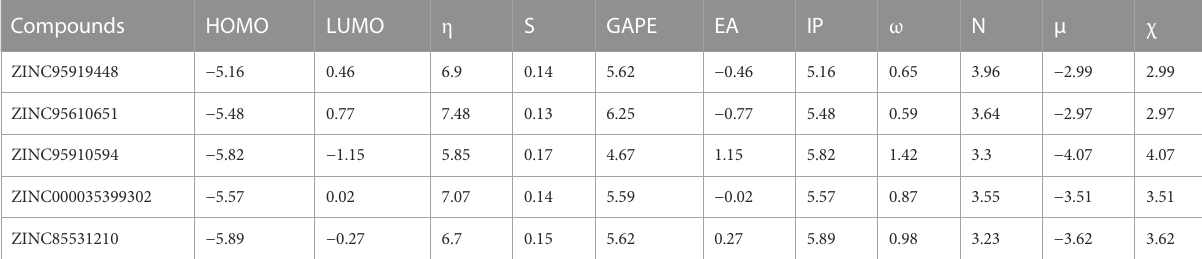
TABLE 4 The Quantum chemical descriptors at B3LYP-D3/6-311G** level. Compounds HOMO